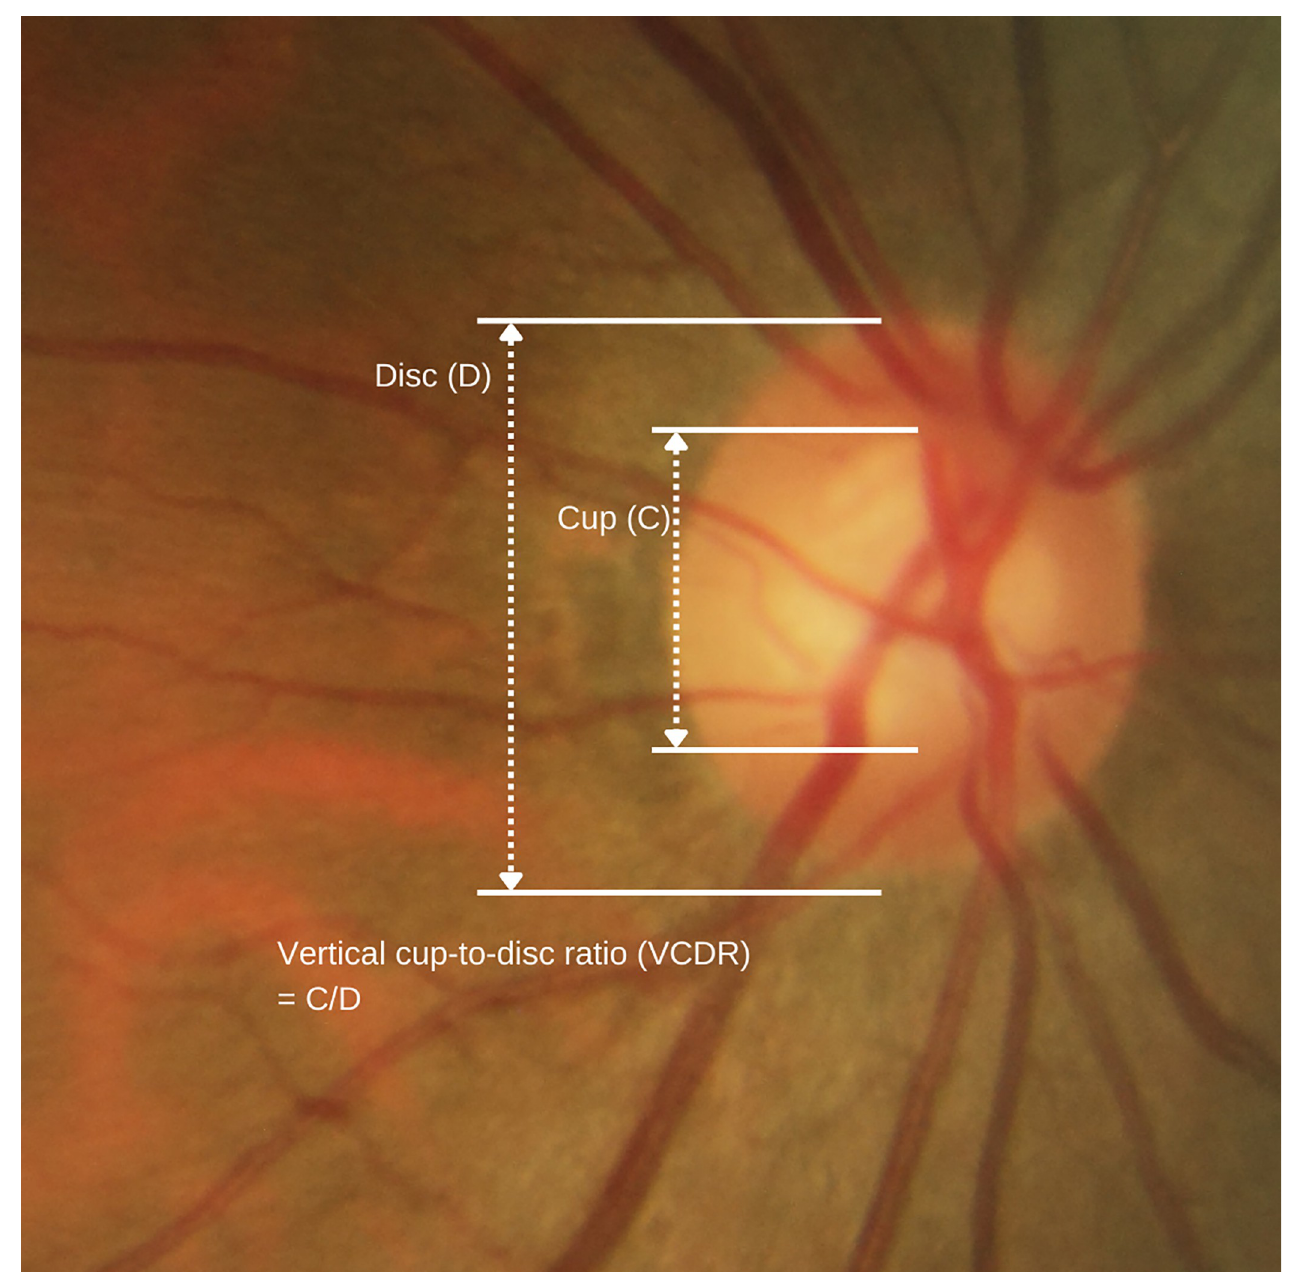
Fig 1. An illustration of the optic nerve head (ONH) and the vertical cup-to-disc ratio (VCDR).